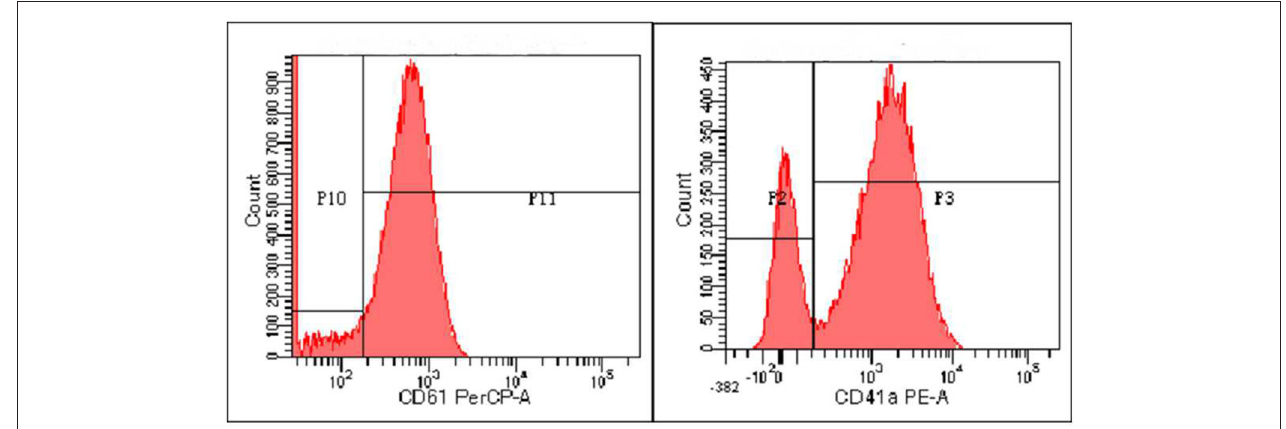
FIGURE 2 | The expression of CD61 and CD41a after transplantation detected by flow